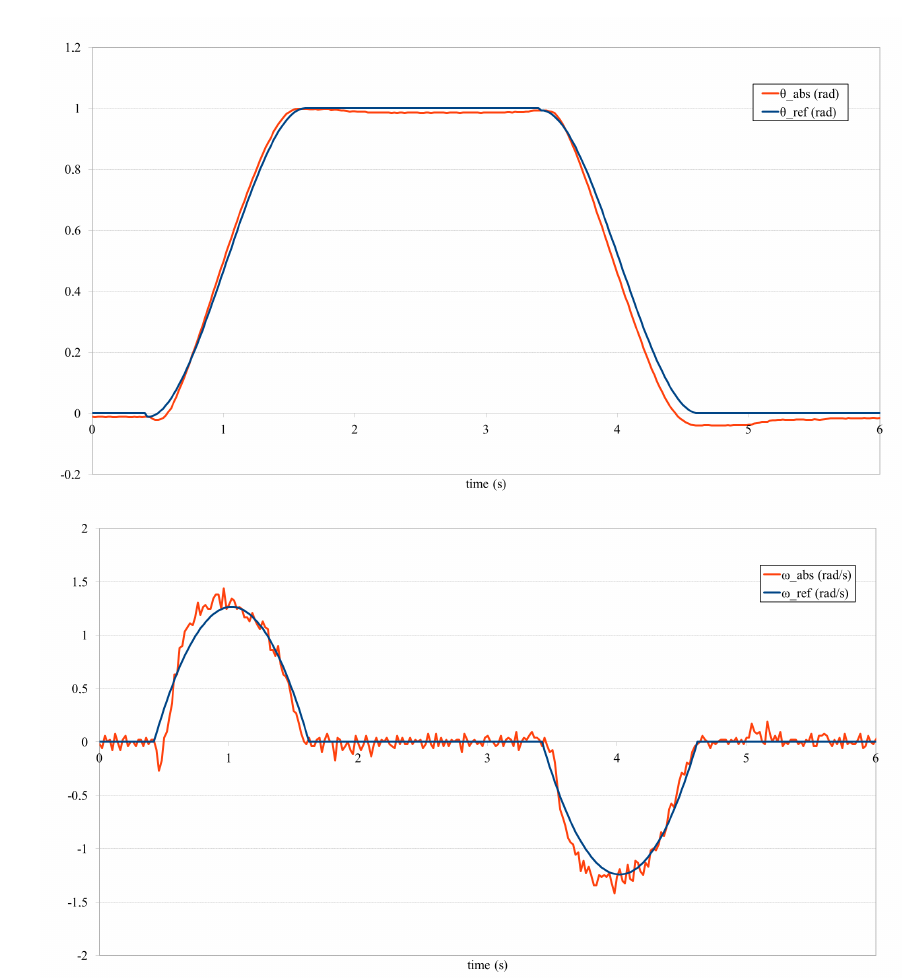
Figure 18. Compliant controller trajectory following in angular position (up) and speed